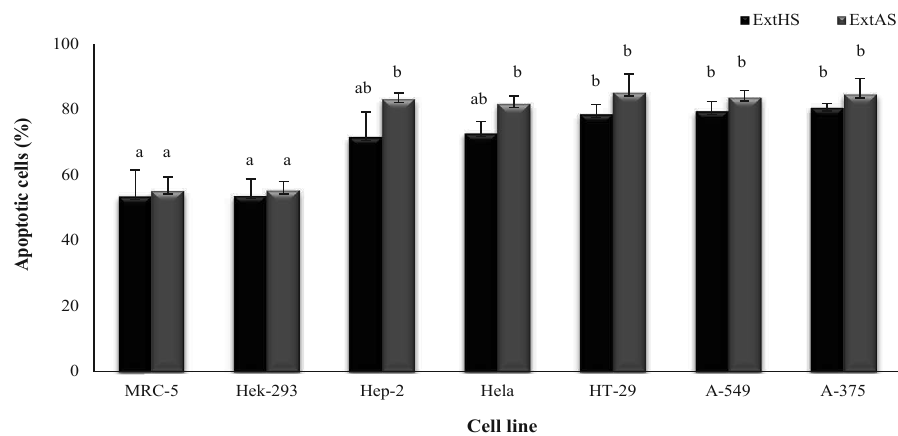
Figure 1 - Percent of cells immunostained in late apoptosis (Annexin V positive/PI positive) and/ or necrosis (PI positive). Results were obtained from three independent experiments. Each bar represents the average percentage of late apoptosis/necrosis ± SD relative to control, which was normalized to 100%. Letters correspond to statistically signi fi cant differences using ANOVA-Tukey test (p ≤